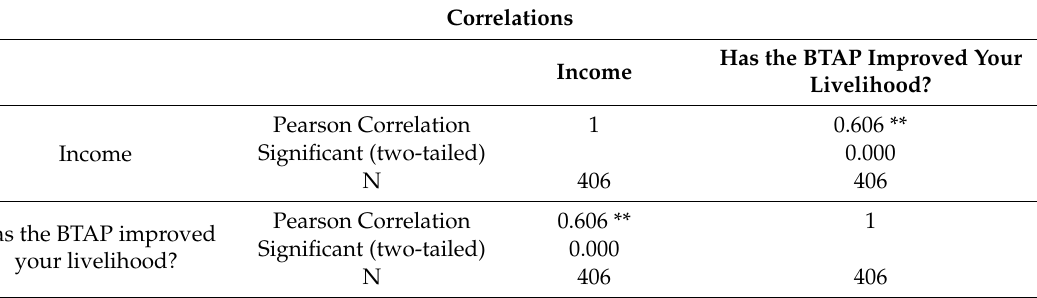
Table A5. Income correlations results.